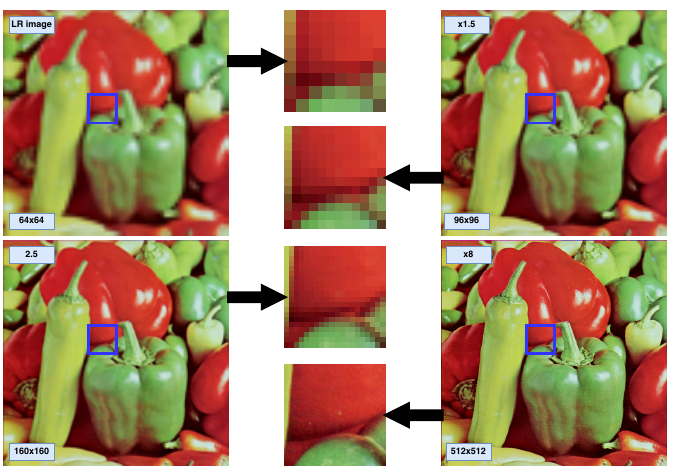
Figure 1. An image in the continuous domain can be presented in arbitrary high